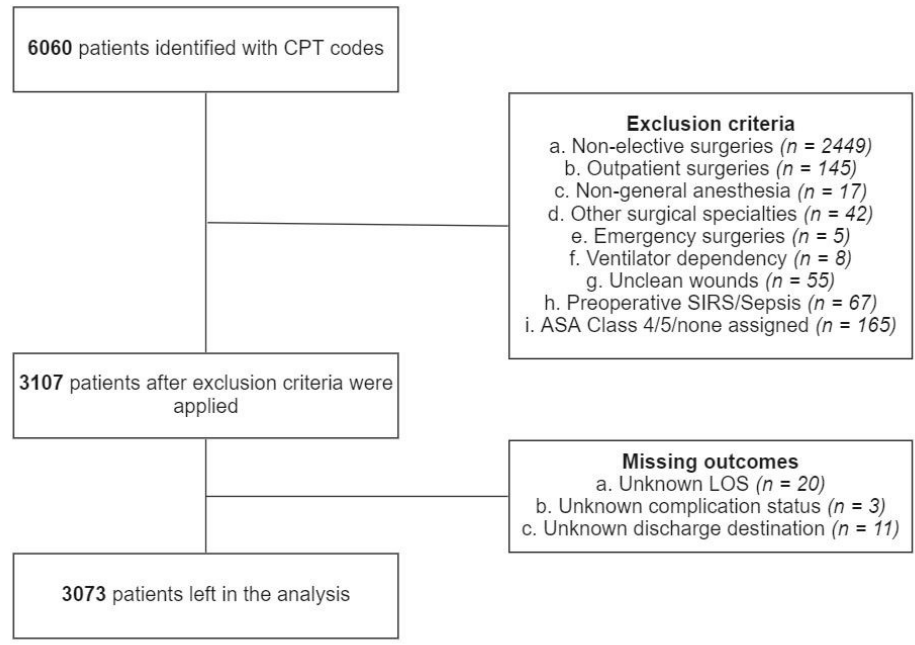
Figure 2. Patient selection process.